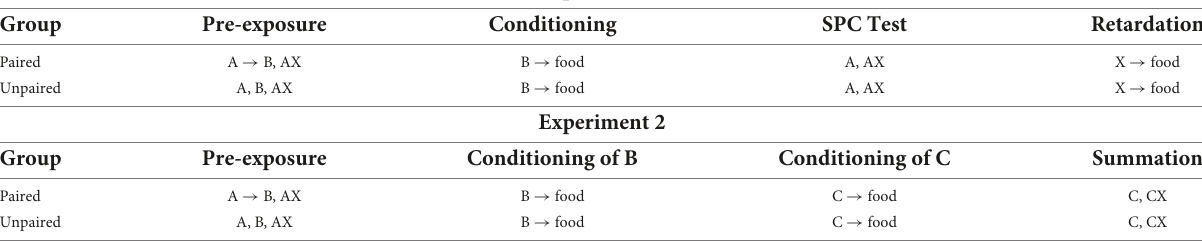
TABLE 2 Inhibitory sensory preconditioning reported by Espinet et al.